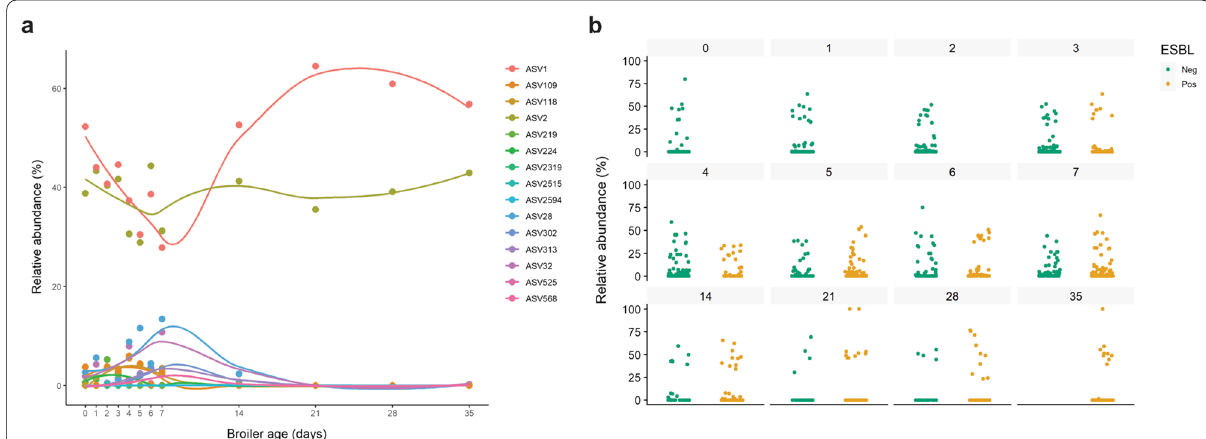
Fig. 3 Relative abundance of Escherichia/Shigella genus . a Relative abundance trends of fifteen amplicon sequence variants (ASVs) recovered from the broilers’ caeca and associated with the Escherichia/Shigella genus . Each dot represents the relative abundance mean of each ASV per time point. b Escherichia/Shigella relative abundance over time in ESBL‑Ec − and ESBL‑Ec + broilers. No differential abundance of Escherichia/Shigella was observed over time between broilers’ groups (ANCOM‑BC, p >